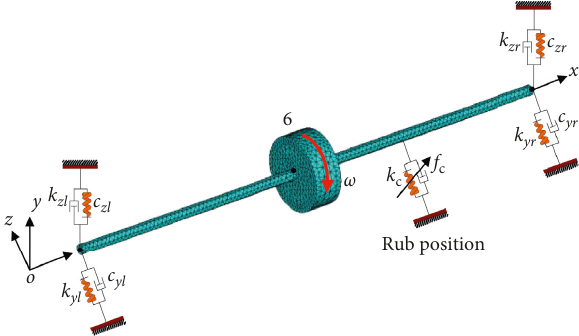
Figure 1: Jeffcott rotor fixed-point rub-impact system Table 1: Specific unit parameters of segments. Segment no.